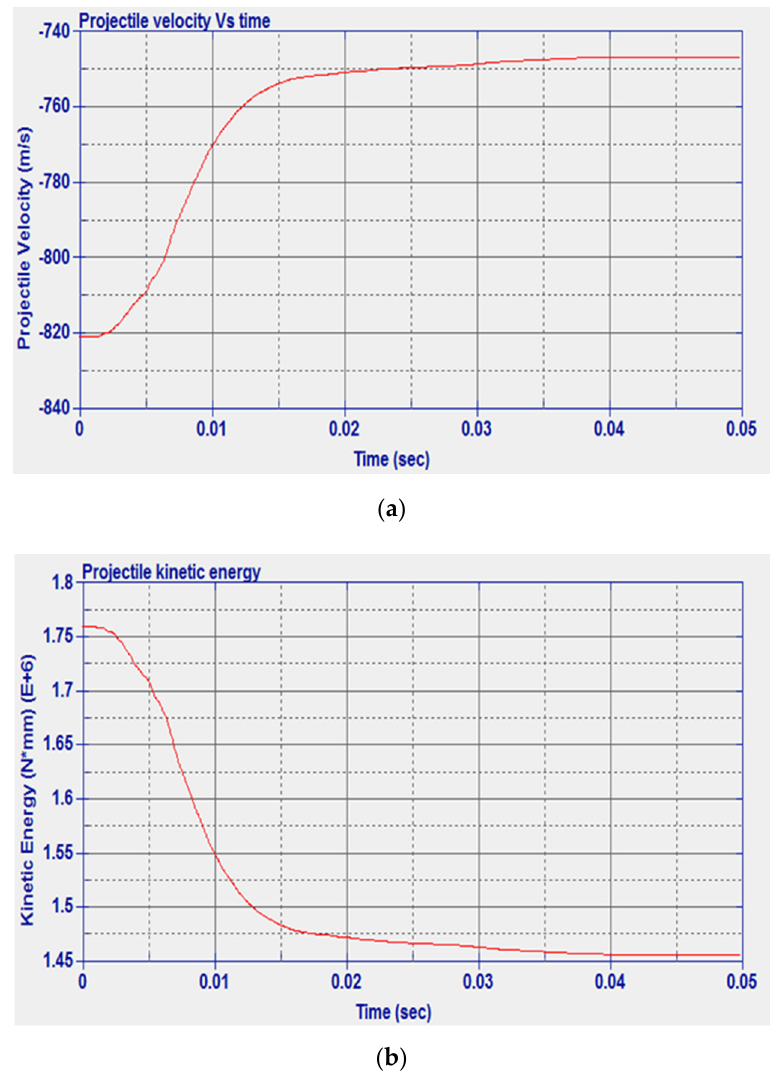
Figure 9. NiTi solid plate: ( a ) Projectile velocity vs. time, and ( b ) kinetic energy vs. time.